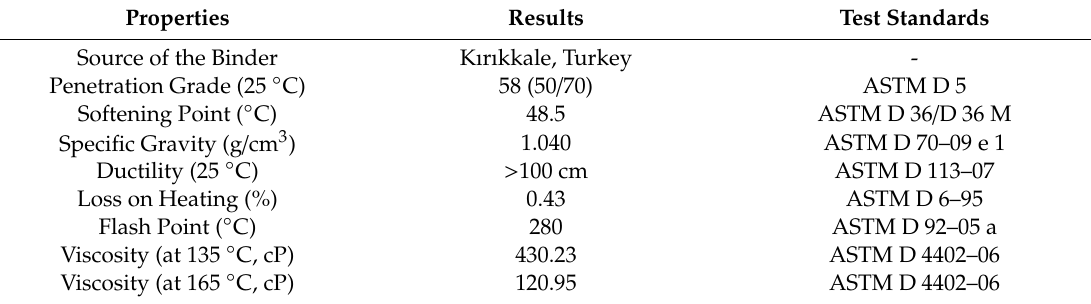
Table 3. Physical properties of the asphalt